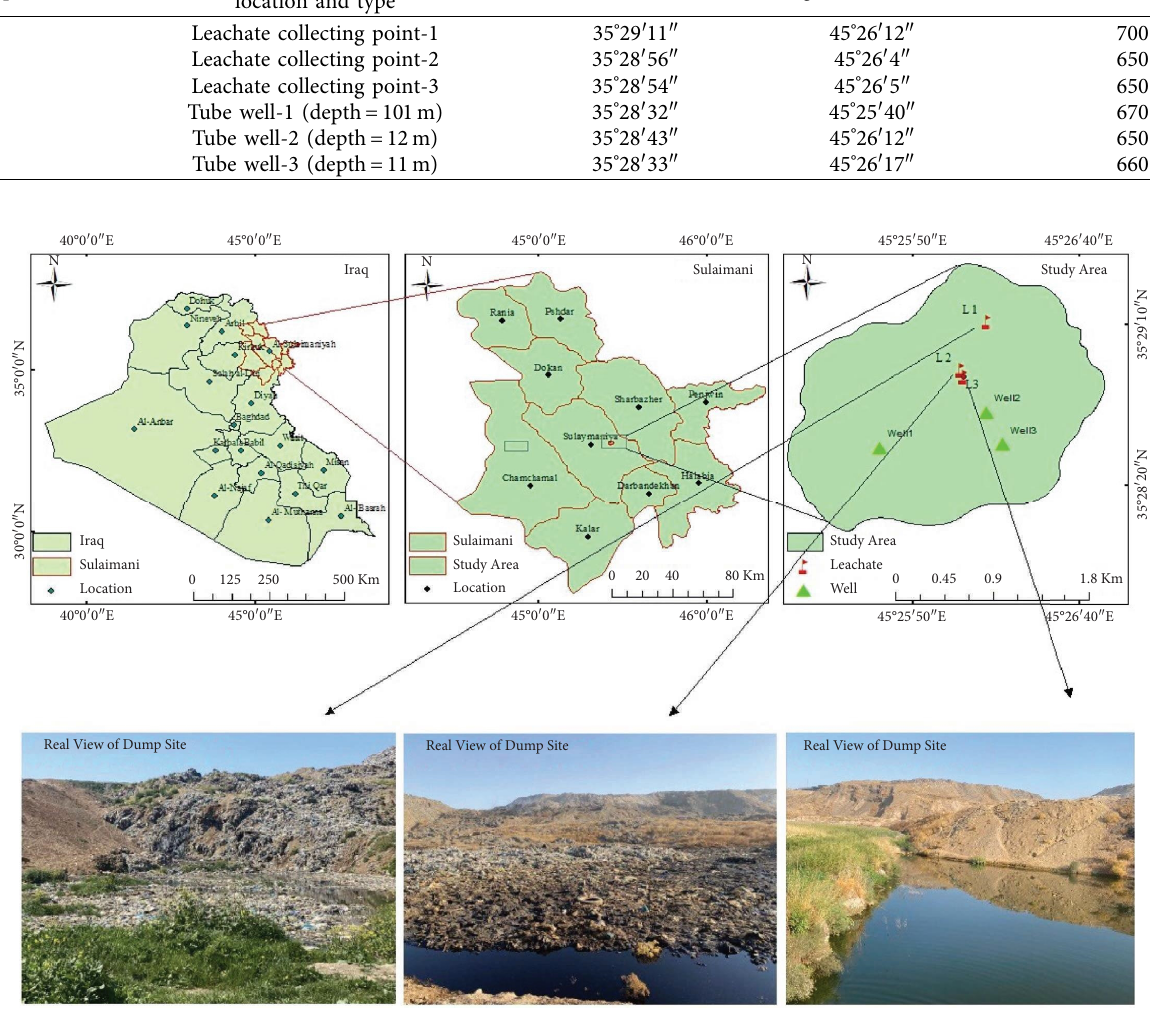
Figure 1: Te location of study area (dumping site and wells) at